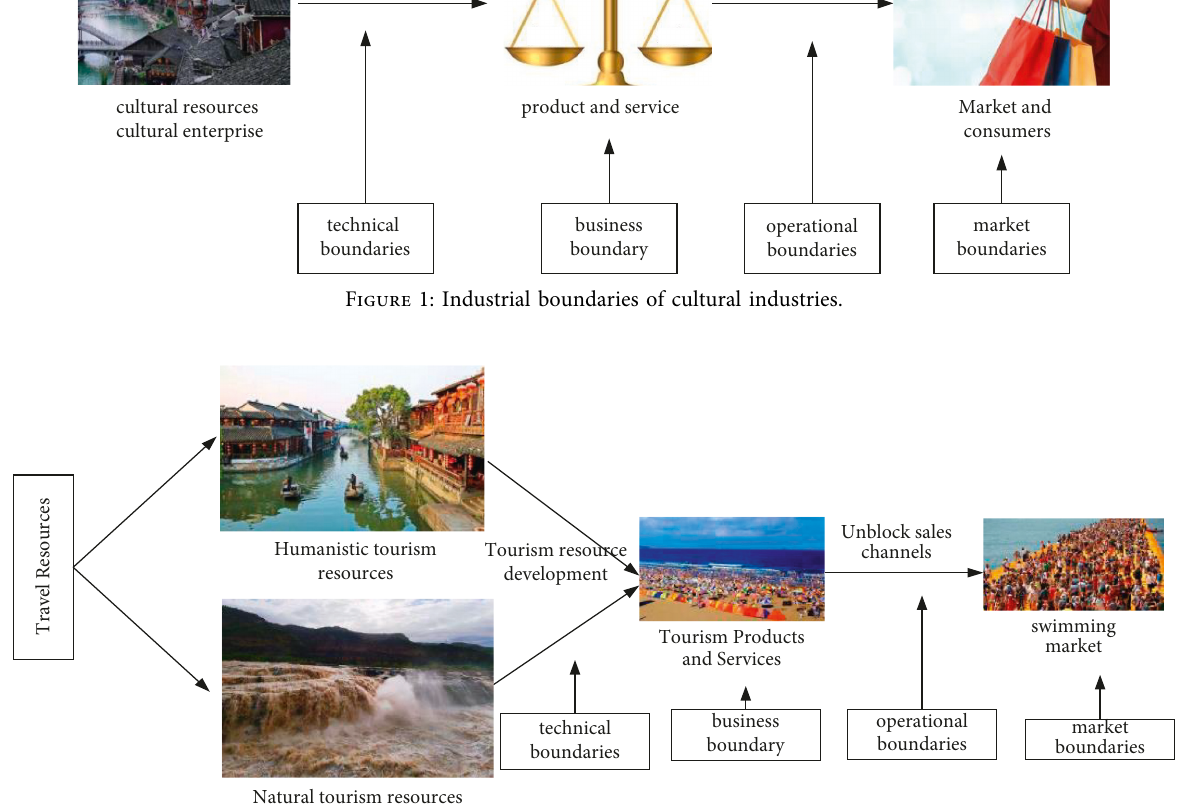
Figure 2: Industry boundary of tourism industry.